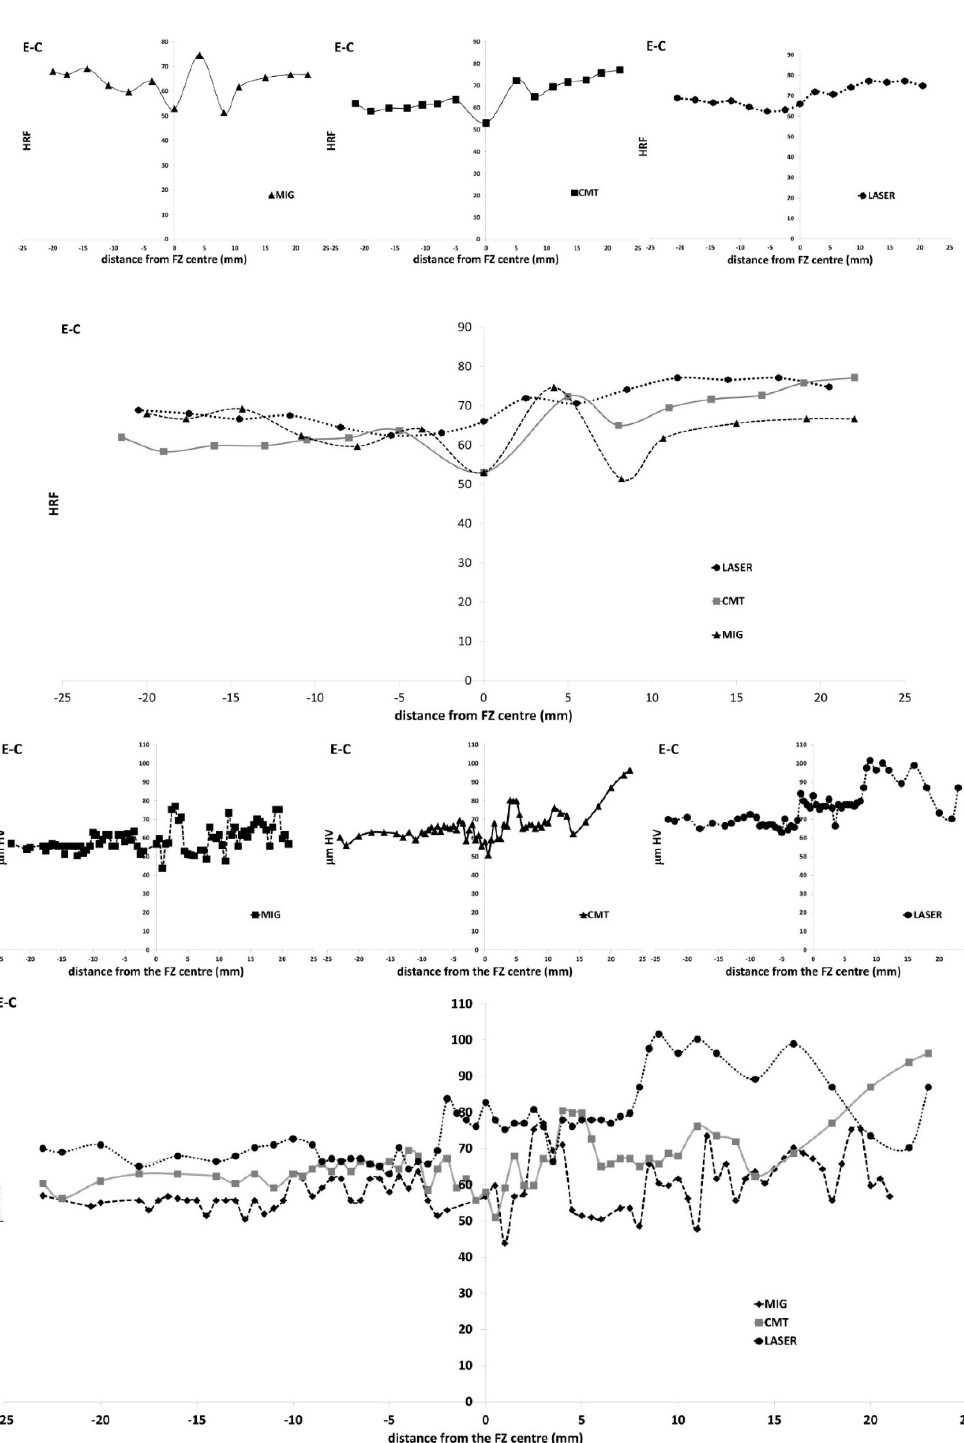
Figure 15. Evolution of the macro-hardness HRF and micro-hardness HV in the E-C combination of the weld for laser, CMT, and MIG. the weld for laser, CMT, and